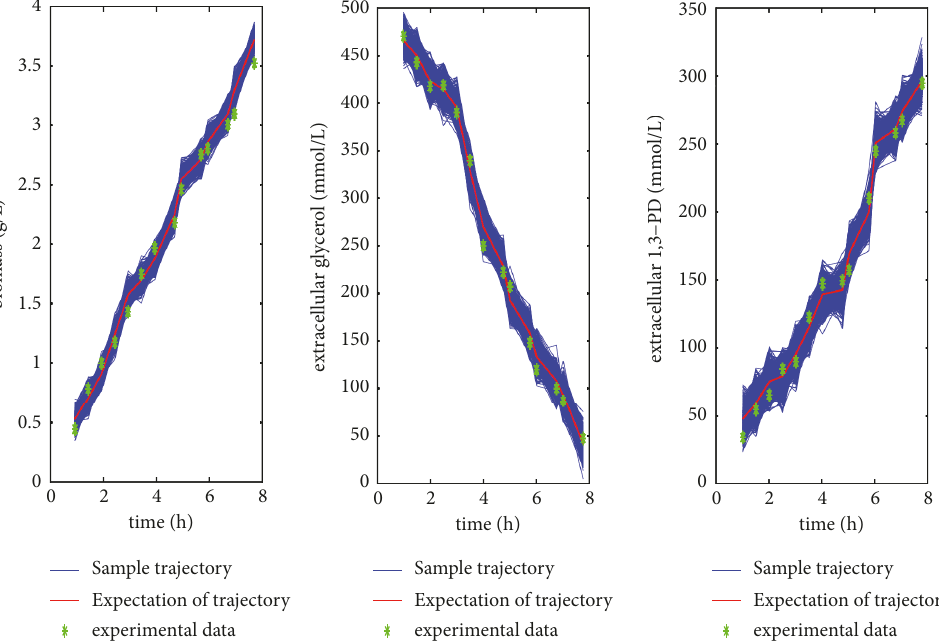
Figure 4: The results of initial glycerol concentration of 509.8913 𝑚𝑚𝑜𝑙/𝐿 and biomass concentration of 0.2245 𝑔/𝐿 with 1000 sample